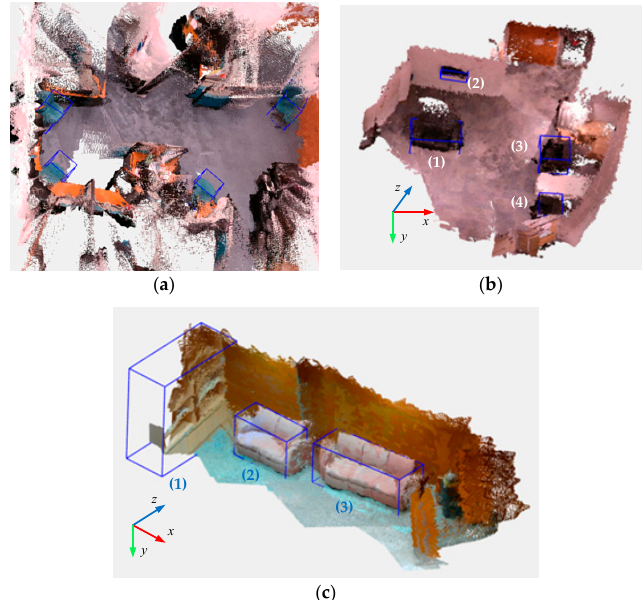
Figure 5. Experiments in a service robot in three indoor scenes: ( a ) an office room, where four chairs are detected; ( b ) an office corner, where three sofas and a television are detected; and ( c ) another corner in an office, where a bookshelf and two sofas are detected. The coordinate systems in ( b ) and ( c ) were the global systems. Table 4. Quantitative experiments of 3D object detection in indoor scenes 1 . 3D Bounding Box (Ground truth) 3D Bounding Box (Estimation)